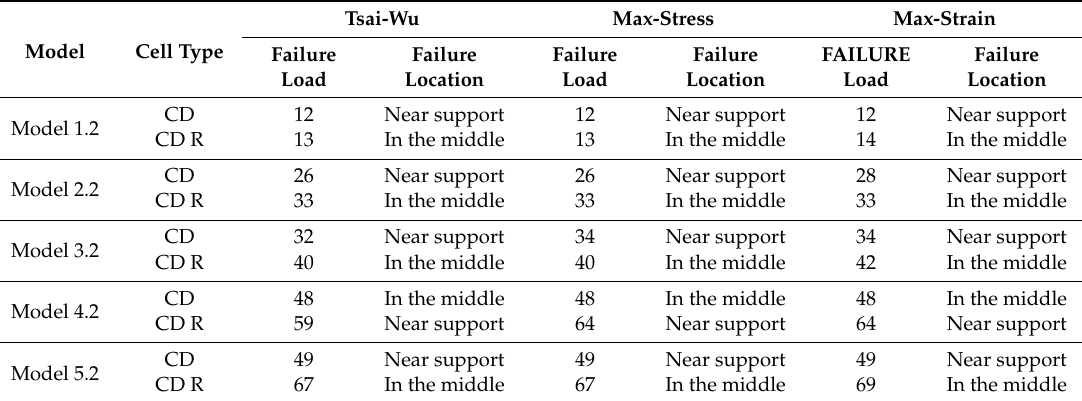
Table 6. Comparison of failure loads and places for models in CD.